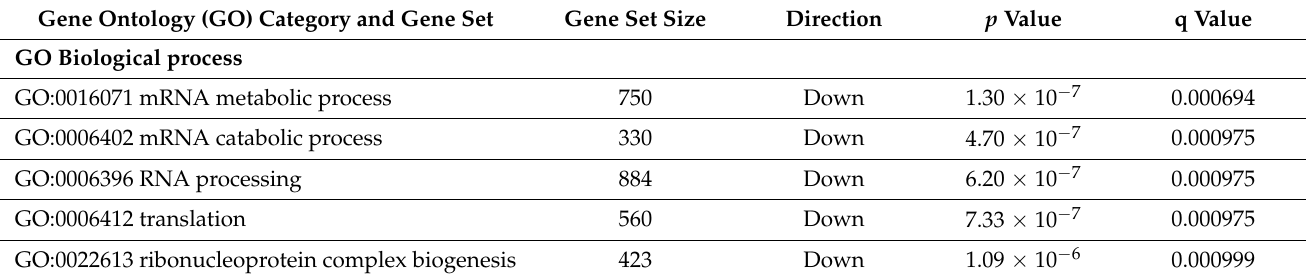
Figure 4. Differential gene expression analysis of FaDu cell line before and after Parsortix microfluidic enrichment demonstrates a cell stress response and downregulation of keratin proteins. Heatmap of differential gene expression analysis of paired unfixed FaDu cells before and after Parsortix enrichment. ( A ) The top 50 differentially expressed genes are displayed, the majority of which are downregulated and involved in mRNA/RNA and ribosomal protein processing. Upregulated genes indicate an oxidative stress response. ( B ) Heatmap of gene expression for specific HNSCC/CTC target markers. Three genes (keratins 17 and 19 and ribosomal protein S6, highlighted within red boxes) demonstrated differential expression and downregulation after Parsortix enrichment; the remaining genes were not differentially expressed before and after enrichment. Table 2. Downregulated differentially expressed genes in Parsortix enriched FaDu cells demonstrate enrichment of mRNA/RNA and ribosomal processing gene sets. Functional enrichment analysis of gene ontology (GO) gene sets (bio- logical process, cell component and molecular function) of downregulated genes in the Parsortix processed FaDu cells. Top five for each domain are displayed. There is a clear pattern of downregulation in mRNA/RNA processing and ribo- somal proteins as seen in cells undergoing a stress response and/or apoptosis.